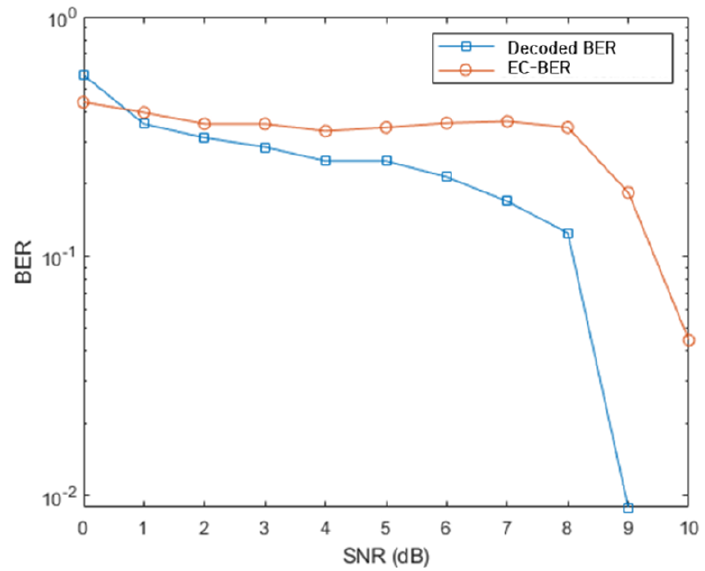
Figure 3. Relation of decoded BER and EC-BER.